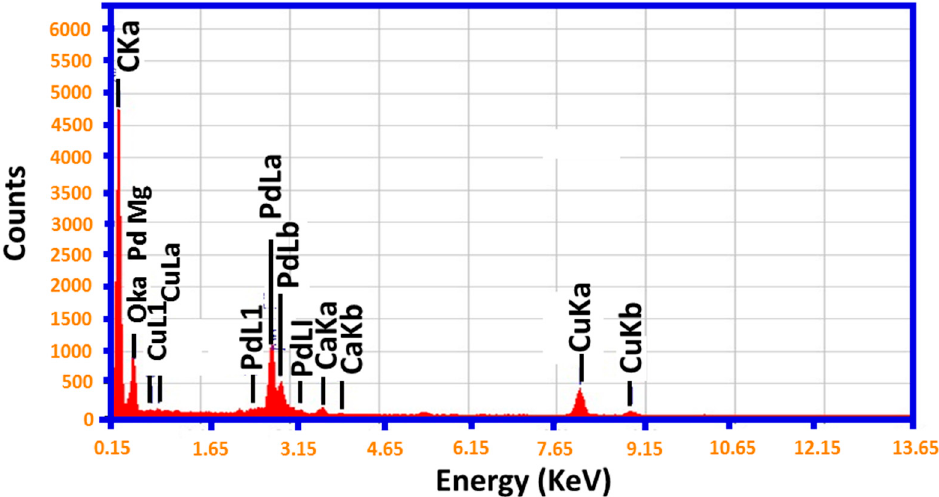
Figure 2. Energy dispersive X-ray spectrum (EDX) of as-synthesized Pd@graphene nanocatalyst (PG-HRG-Pd-1) confirming the composition of product.